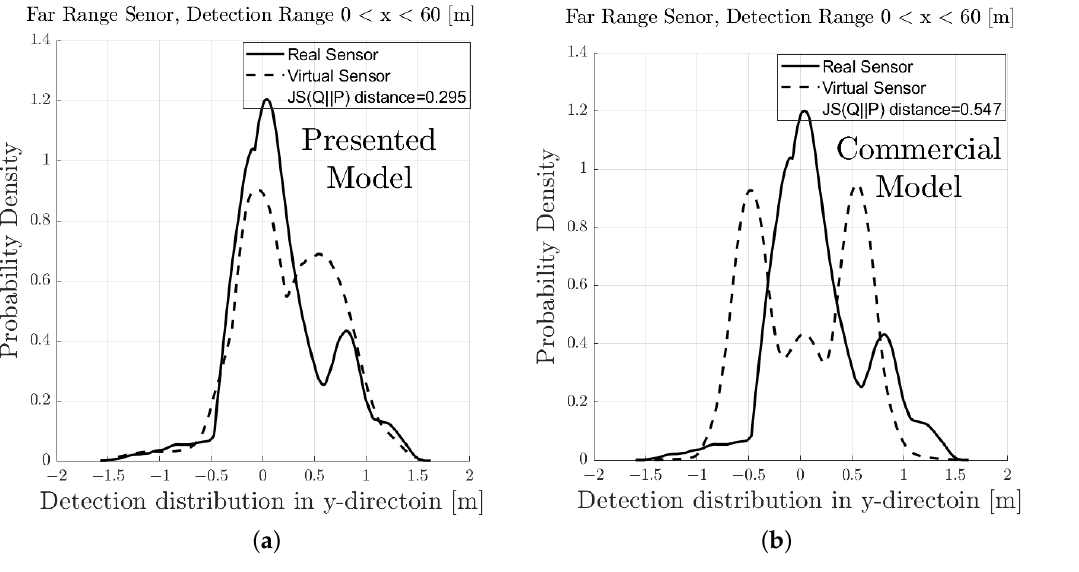
Figure 13. Visual comparison and evaluation of the probability distribution function (PDF) of the deviation of the measured and simulated radar point clouds with respect to the reference point in the near-range detection sector. ( a ) PDF of the deviation in the y -direction from P ref ( x , y ) of the real sensor and sensor model presented in this paper. ( b ) PDF of the deviation in the y -direction from P ( x , y ) of the real sensor and sensor model for commercial ref